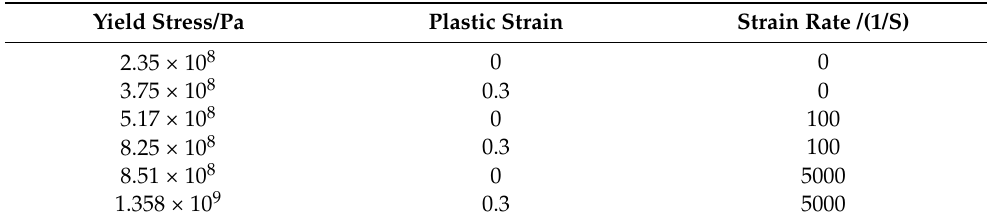
Table 2. Q235 steel material